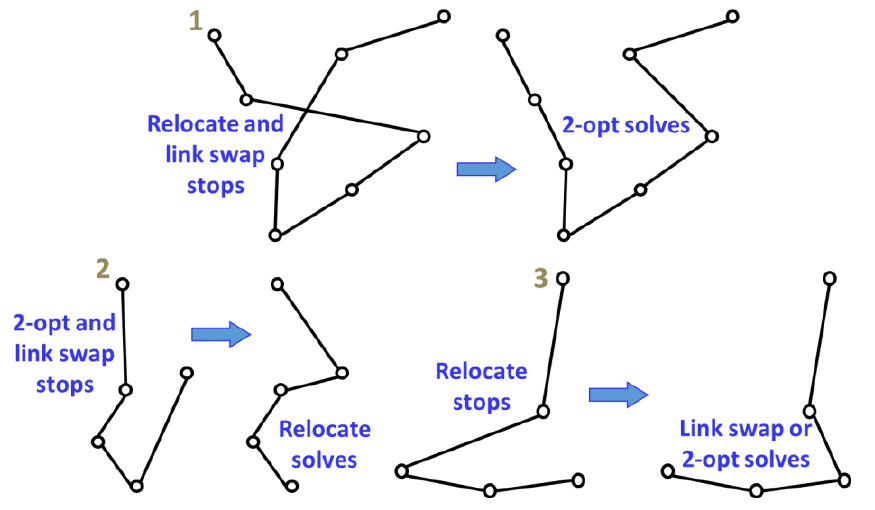
Figure 12. Operators have complementary search spaces.